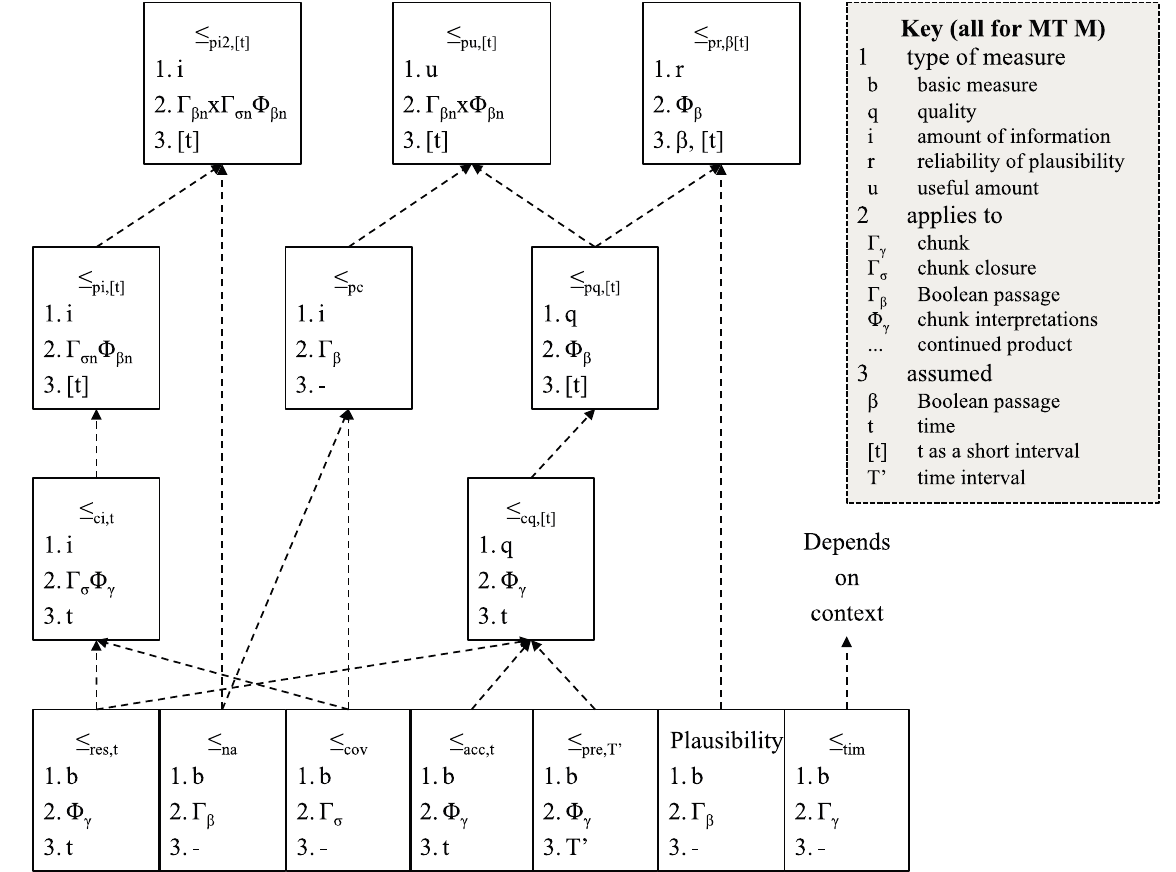
Figure 8. Relationship between